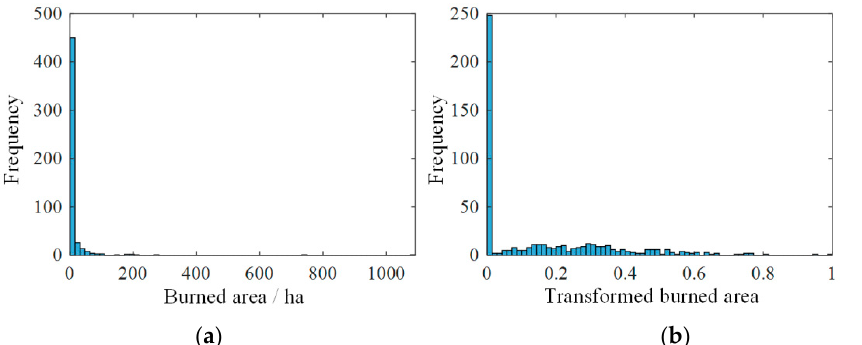
Figure 1. Histogram of ( a ) original burned area; ( b ) transformed burned area using logarithm transformation and normalization.